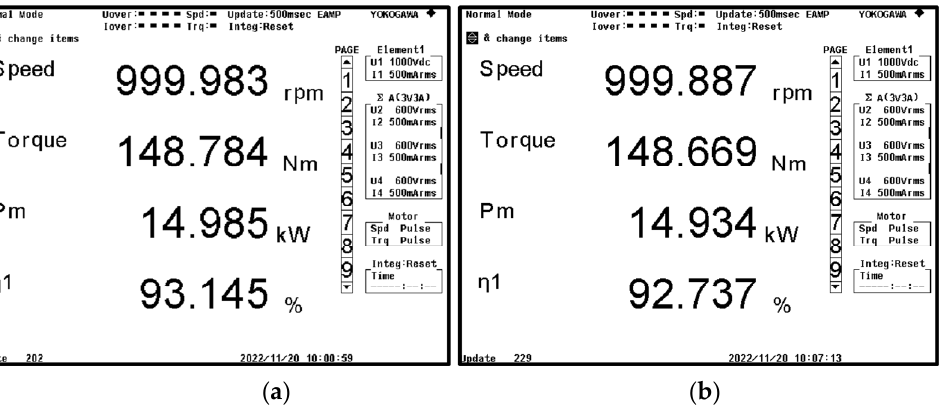
Figure 7. The comparison diagram of motor efficiency at speed of 1000 r/min and torque of 150 N · m. ( a ) VCSIM, ( b ) the proposed method.